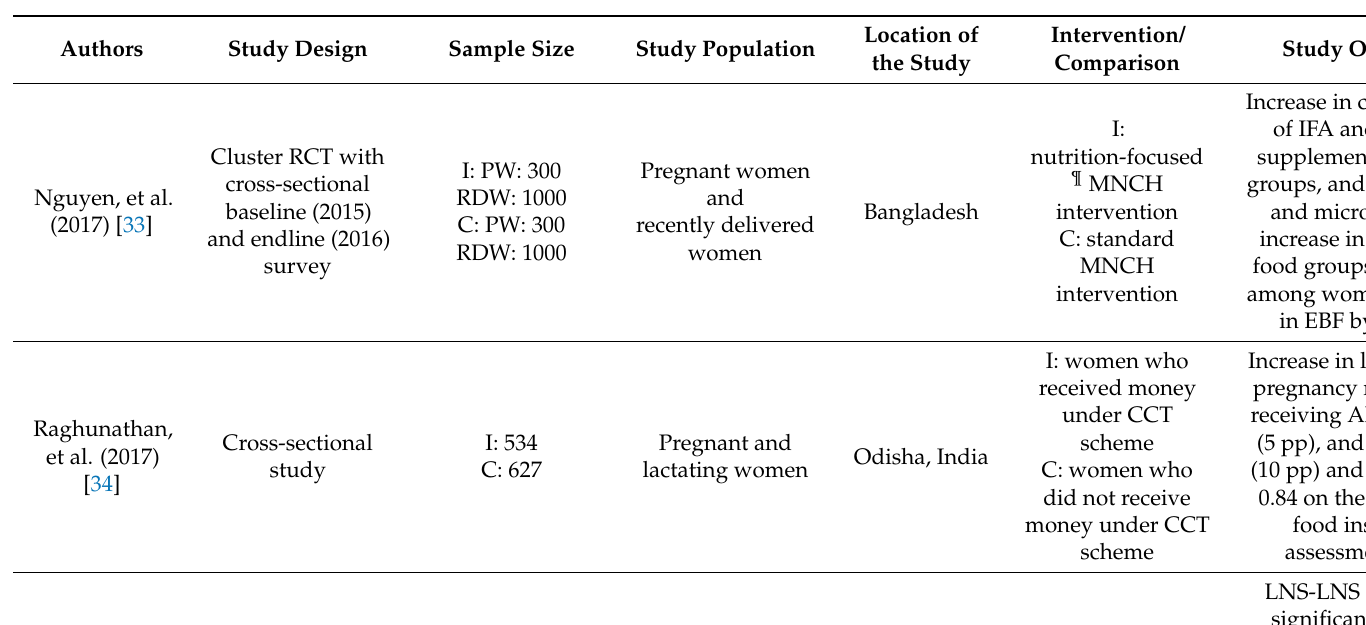
Table 2. Characteristics of the included studies ( n =